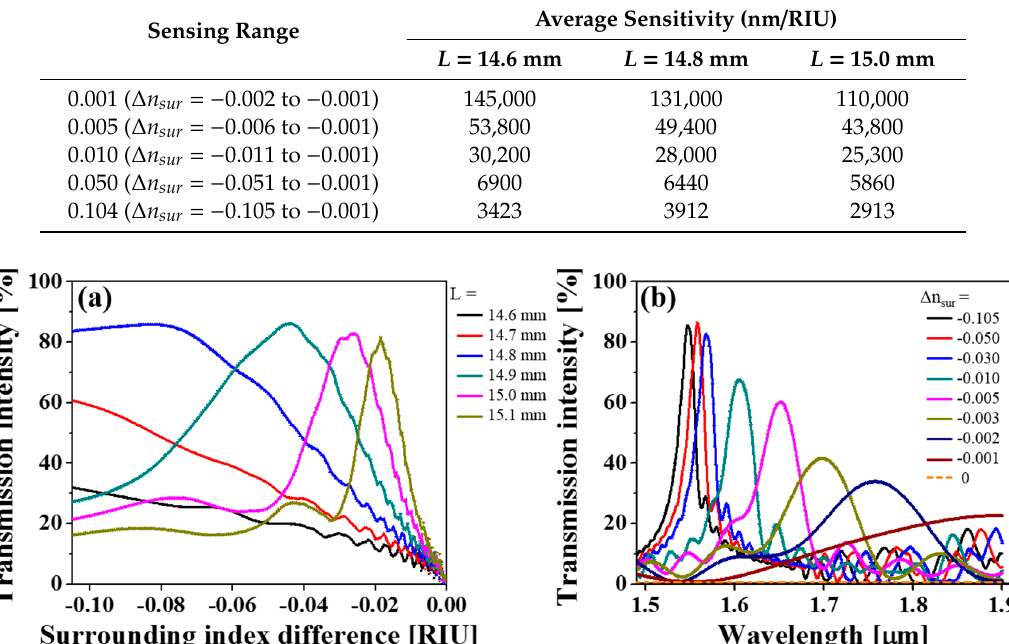
Figure 6. ( a ) Calculated transmission curves for the proposed sensor as a function of the surrounding index difference at λ = 1550 nm under different interaction lengths and ( b ) its spectral responses based on an SMF (UHNA1) with L = 14.8 mm. 5. Conclusions In summary, a highly sensitive fiber-optic RI sensor, exploiting an SMF with an optically reshaped core, has been proposed and designed. RI detection can be realized by either monitoring the output intensity alteration or the peak wavelength shift. Leaky-mode and MMI theories are primarily involved in investigating the transmission behavior of the sensor. The impact of the interaction length on the sensor performance was analyzed particularly, corroborating an excellent flexibility in tuning the operating range and sensitivity. For a standard step-index fiber with a completely reshaped core of 14.8 mm in length, ultrahigh average sensitivities of 185 dB/RIU and 3912 nm/RIU were obtained in the range of 1.339 − 1.443 for the intensity- and wavelength-based interrogations, respectively, which are much higher compared to the conventional heterostructure- based designs. The calculations also indicate that the proposed sensing scheme can be applied to different types of SMFs, regardless of their core diameter and NA. The proposed RI sensor has potential for use in a wide range of possible applications for measuring the RI and concentration of liquids or gases in industry and bioscience. Our future work will focus on the correction and improvement of the negative modification in RI. Currently, the experimental demonstration is still under investigation due to the fact the entirely negative modification of RI in fusion silica-based SMFs is difficult to achieve via our own ultrafast laser writing system [35,43]. Special SMFs made of crystal materials, as well as visible light-based femtosecond laser pulses [26], are under consideration to implement ULI-based fiber reshaping. In